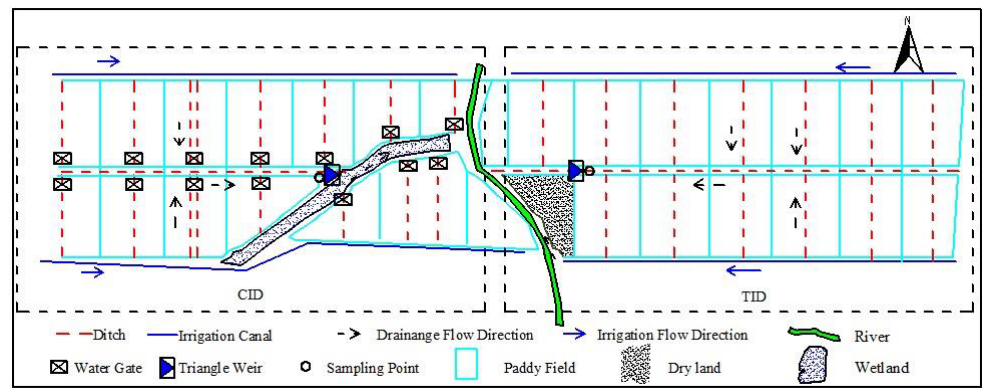
Figure 1. The layout of the study area.